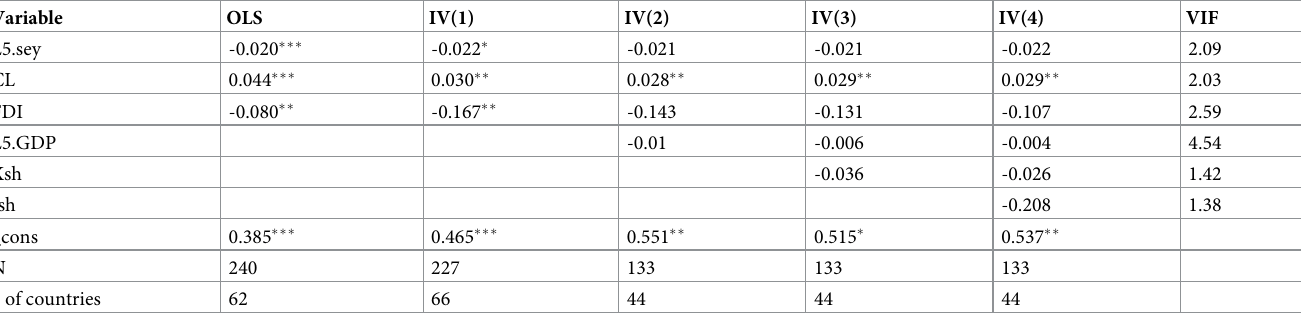
Table 8. Replication results of selected regressions in LSZ (1998) with IV estimation.